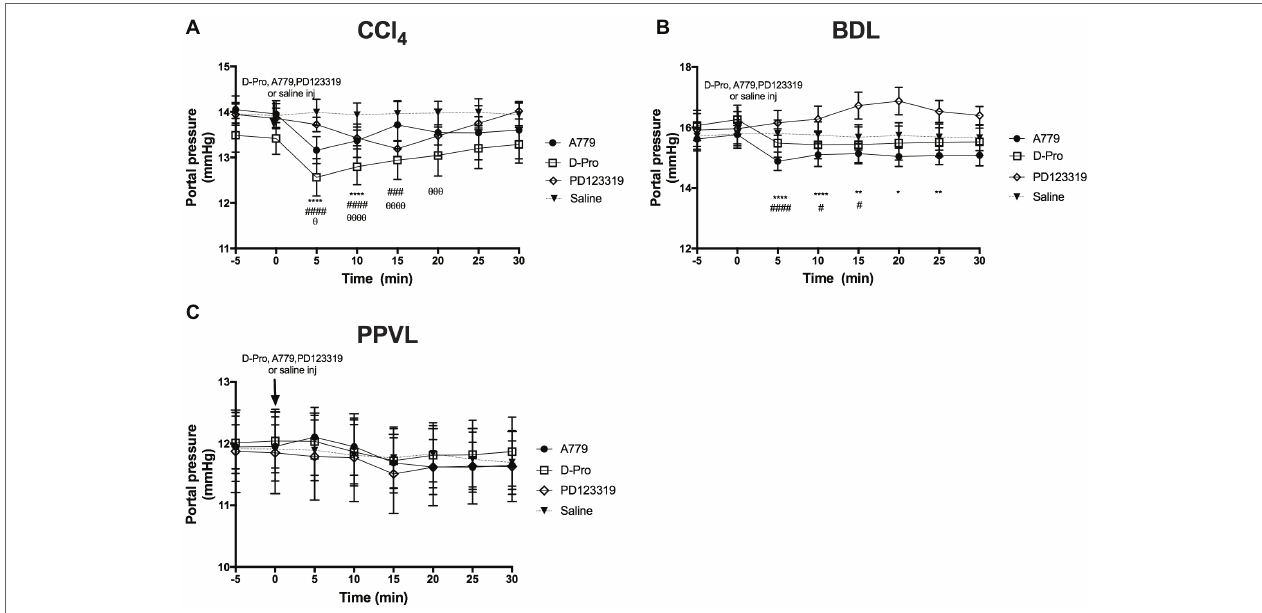
FIGURE 3 | Changes in portal pressure (PP) after intravenous bolus injections of either the MasR blocker A779 (10 μ g/kg), MrgD blocker D-Pro (10 μ g/kg), or AT2R blocker PD123319 (1 mg/kg) in CCl 4 (A) , BDL (B) , and PPVL (C) models. Saline injection served as the control. Pressure measurement was commenced 5 min prior to injection and continued for 30 min after the injection. Each time point represents the mean ± SEM profile from six to seven rats per treatment group. **** p < 0.05, ** p < 0.01, * p < 0.05 baseline vs. A779, #### p < 0.05, ### p < 0.005, # p < 0.05 baseline vs. D-Pro, θθθθ p < 0.05, θθθ p < 0.01, θ p < 0.05 baseline vs.